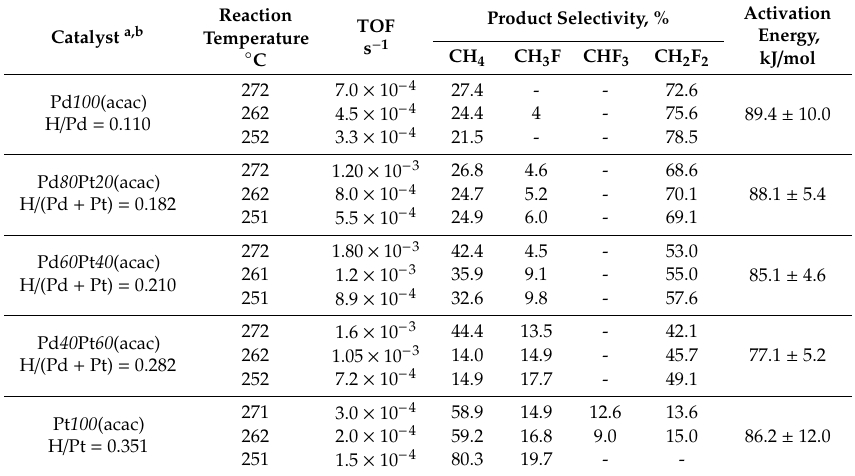
Table 4. CHClF 2 hydrodechlorination on two series of Pd–Pt / C catalysts. Turnover frequencies, product selectivities, and activation energies, acac series after additional calcination at 300 ◦ C, 1